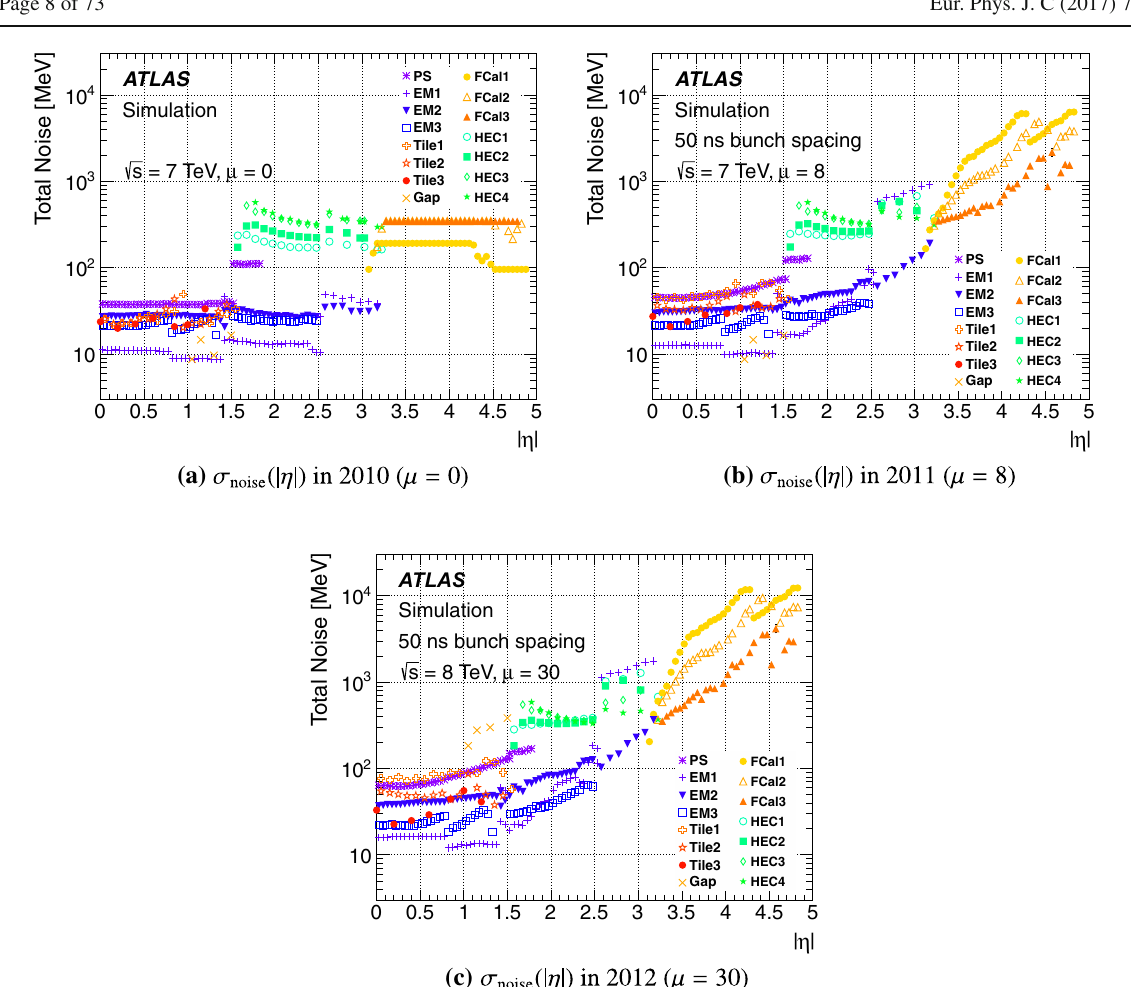
with μ = 30. The various colours indicate the noise in the pre-sampler ( PS ) and the three layers of the LAr EM calorimeter, the three layers of the Tile calorimeter, the four layers of the hadronic end-cap ( HEC ) calorimeter, and the three modules of the forward ( FCAL )